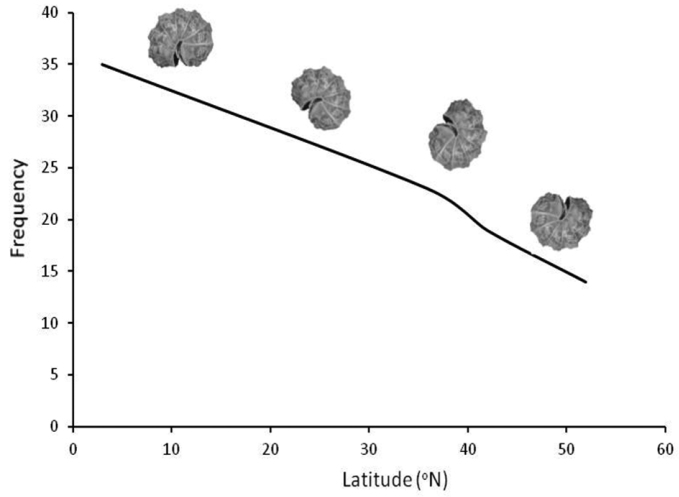
Reduction of the relative contribution of ‘rollers’ (isopods able to conglobate) among the various isopod ecomorphs with increasing latitude (based on Schmalfuss 1984).